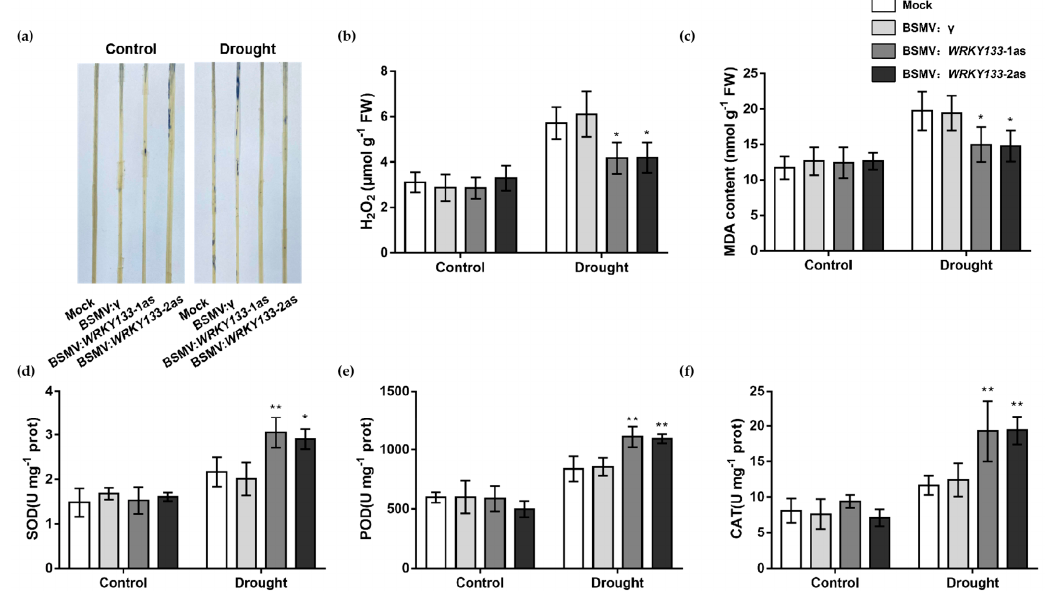
Figure 9. ROS accumulation, MDA content and antioxidant enzyme activities in TaWRKY133 gene-silenced wheat under 10 d of drought stress. ( a ) NBT staining. ( b ) H 2 O 2 accumulation. ( c ) MDA content. ( d ) SOD activity. ( e ) POD activity. ( f ) CAT activity (* p < 0.05 and ** p < 0.01). No asterisk means non-significant difference.